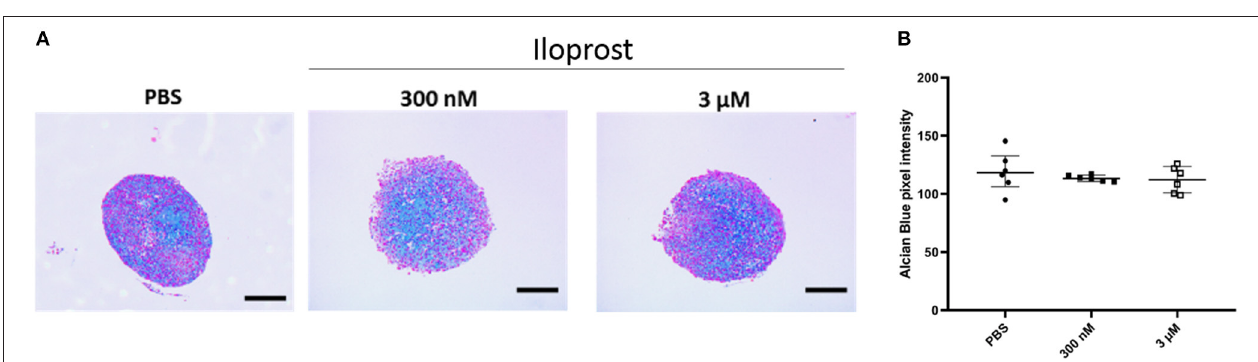
FIGURE 6 | Effect of Iloprost on cartilage formation capacity of chondrogenically induced MSCs. (A) Alcian Blue stained paraffin sections of cartilage pellets after 21 days of incubation in chondroinductive media, supplemented with different concentration of Iloprost (300nM and 3 µ M, respectively) or PBS as control. (B) Quantification of the Alcian Blue staining. Scale bars: 200 µ m; n = 6.